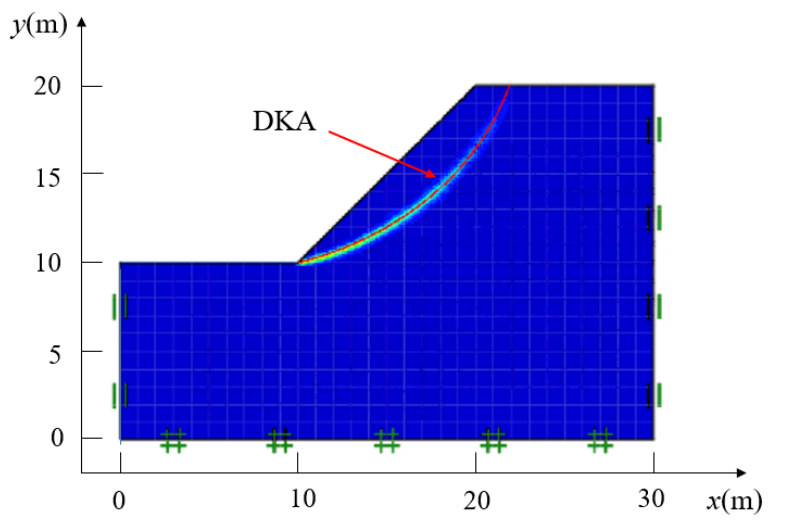
Figure 5. Geological profile of the reference case. Table 1. Statistical properties of soil parameters for the reference case [23].